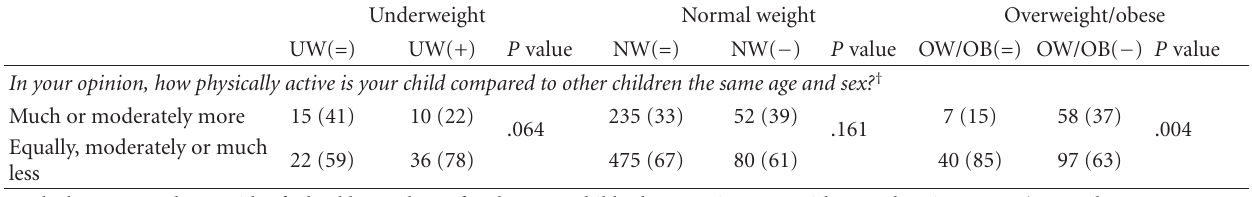
Table 3: Comparison of physical activity level and fitness of children within a given body weight group perceived accurately or not.